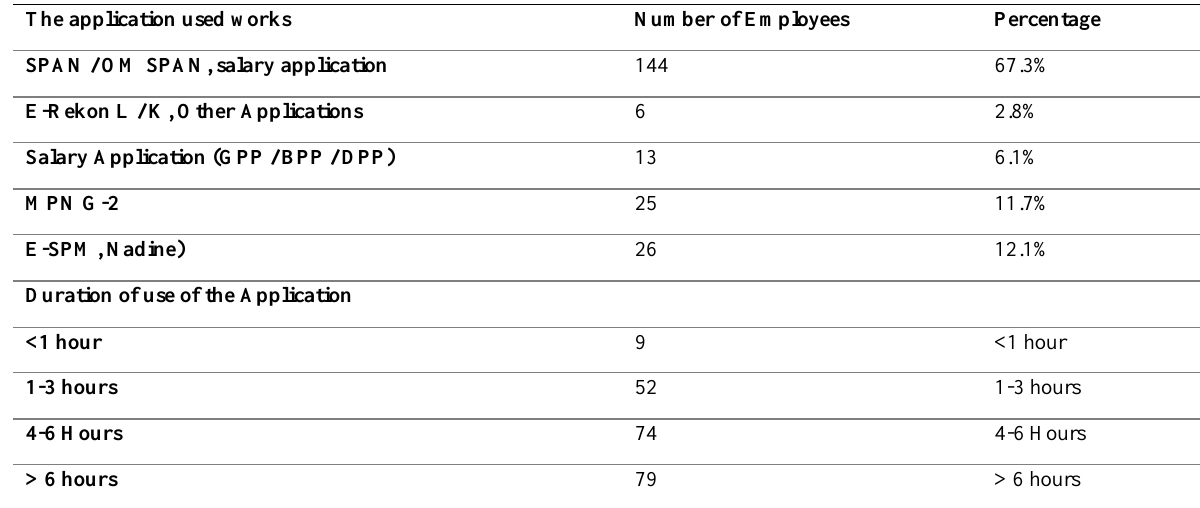
Table 3: Description of Income, Applications Used Work and Duration of